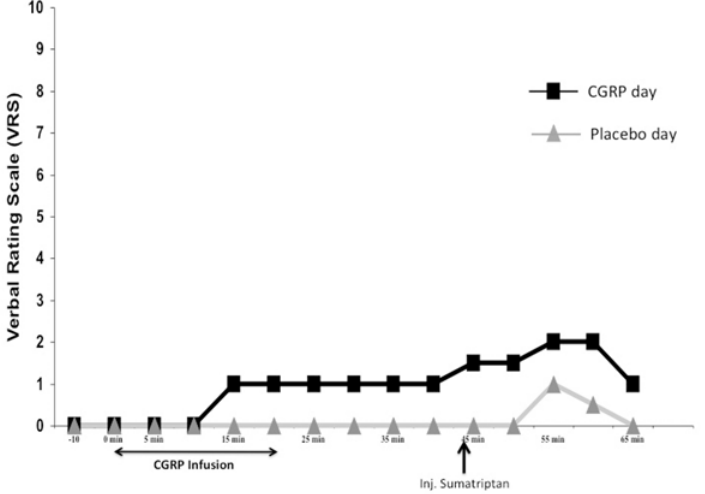
Fig 4. Headache score: Median headache score on the verbal rating scale (VRS) in 27 healthy volunteers. Black line with squares is the headache score on the CGRP day while gray line with triangles is headache score on the placebo